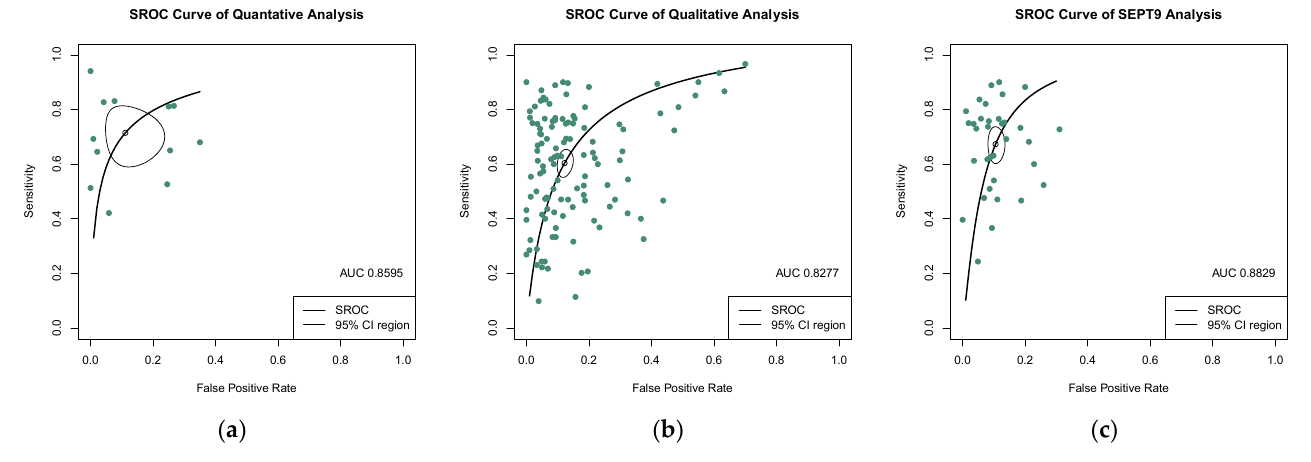
Figure 4. SROC curves of diagnostic value for ( a ) the quantitative detection subgroup; ( b ) the qualitative detection subgroup; ( c ) the SEPT-9 methylation detection subgroup. 95% CI, 95% confidence interval; AUC, the area under the curve; SROC, summary receiver operating characteristic.